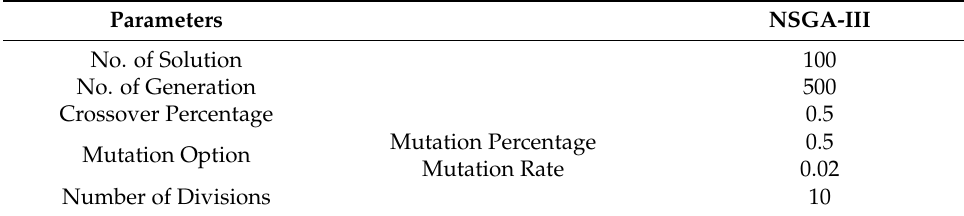
Table 5. Parameters of